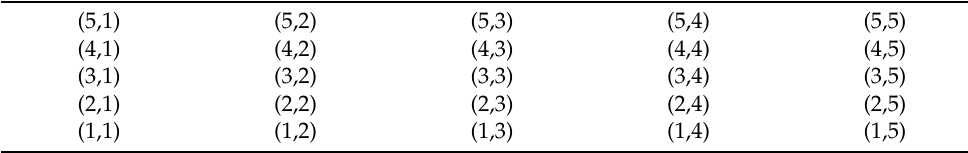
Table 1. Grid ID representation in a sensor network area.